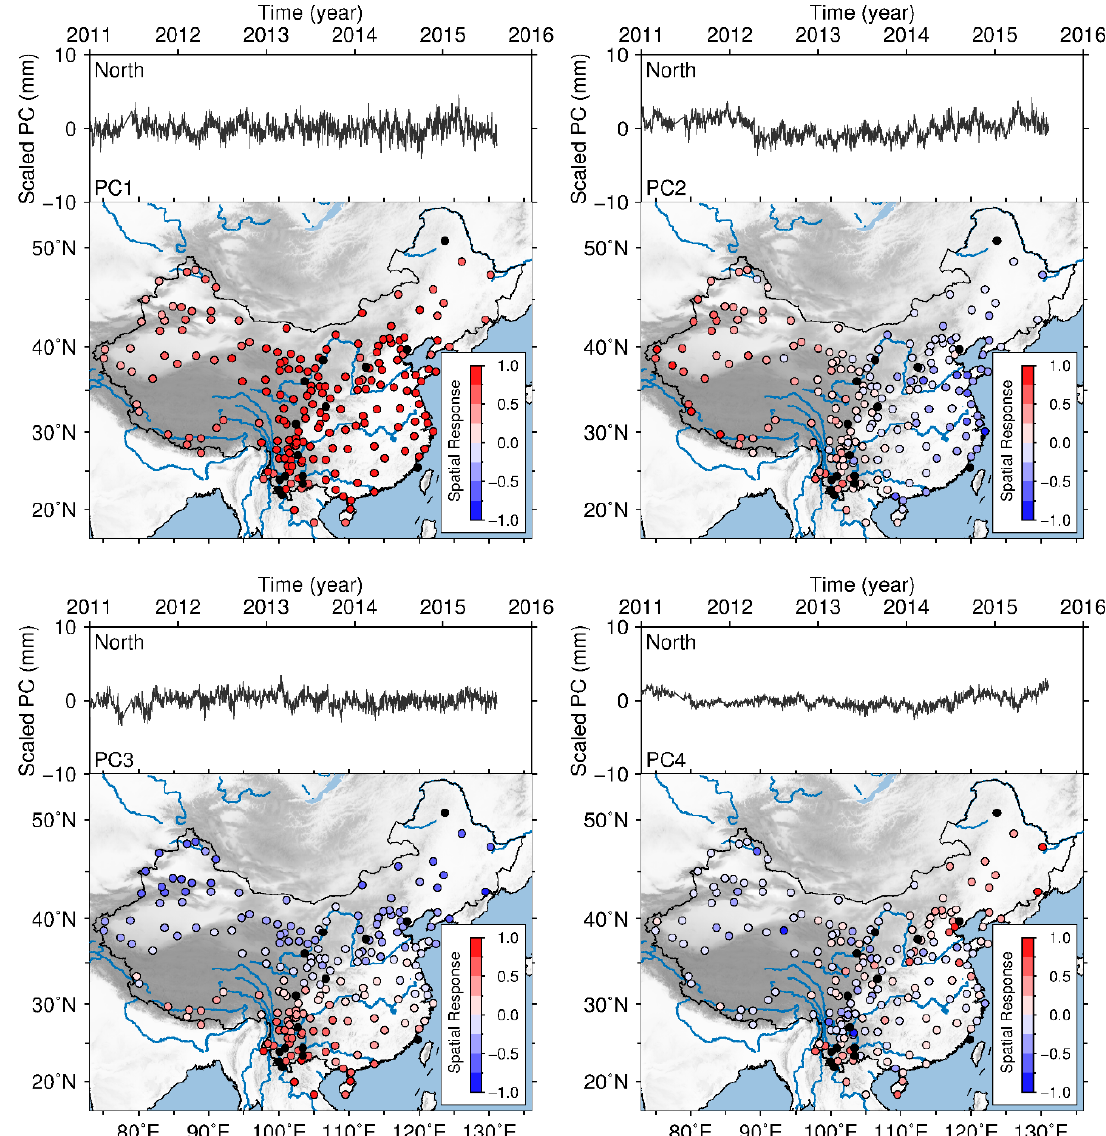
Figure A3. Same as Figure 4, but for the north component.